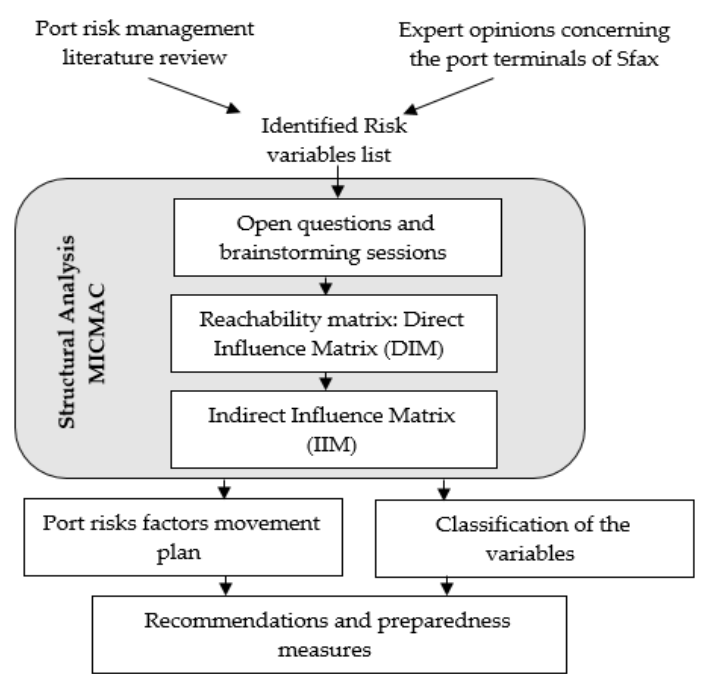
Figure 1. Flowchart of the proposed approach.